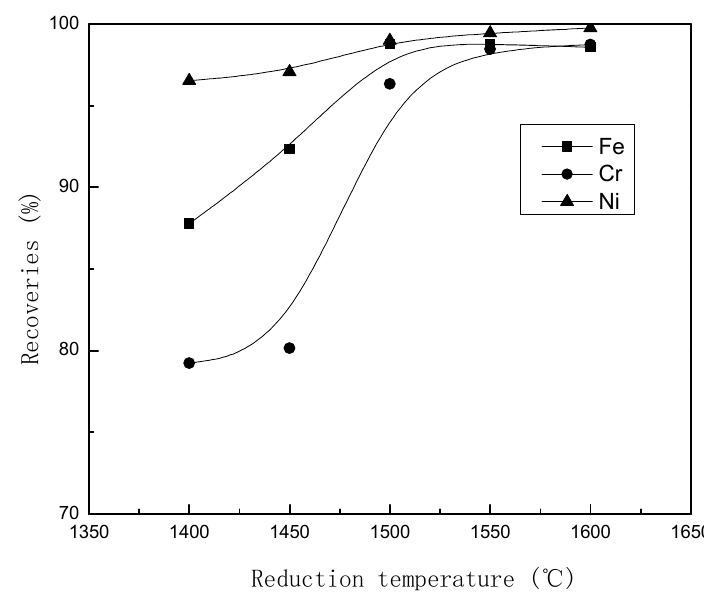
Figure 4. Effect of reduction temperature on metals recoveries.